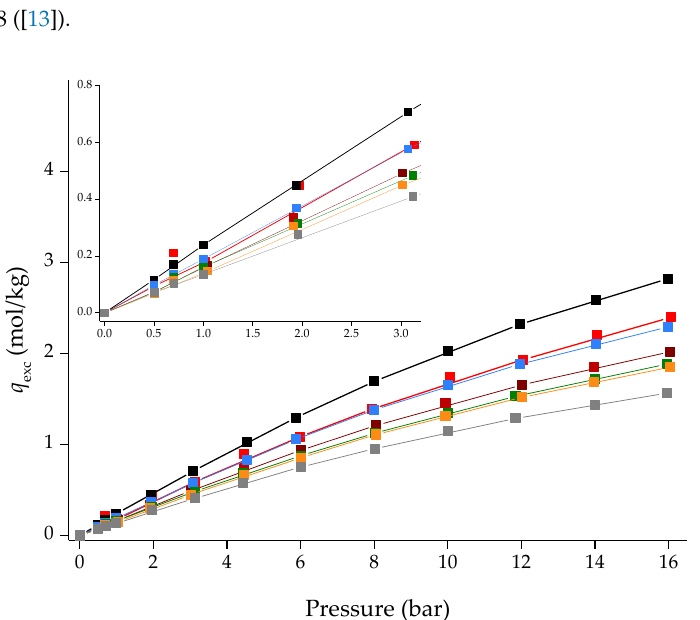
Figure 11. CH 4 adsorption/desorption equilibrium isotherms for ZIF-8 and different IL@ZIF-8 com- posites containing the same IL molar loading at 303 K. Symbols denote both adsorption and desorp- tion data, respectively. Lines are guides to the eye. Symbols: ZIF-8; [C 6 MIM][B(CN) 4 ]@ZIF-8 (low); ◼ [C 2 MIM][Ac]@ZIF-8 ( [13] ); [C 6 MIM][B(CN) 4 ]@ZIF-8 (low); ◼ [C 6 MIM][Cl]@ZIF-8 ( [13] ); ◼ [C 6 MIM][C(CN) 3 ]@ZIF-8 ( [13] ); ◼ [C 6 MIM][N(CN) 2 ]@ZIF-8 ( [13] ) and ◼ [C 6 MIM][NTf 2 ]@ZIF-8 ( [13] ).